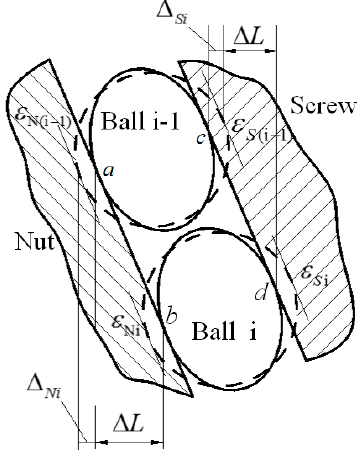
Figure 4. Single nut ball screw pair (SNBSP) load condition.